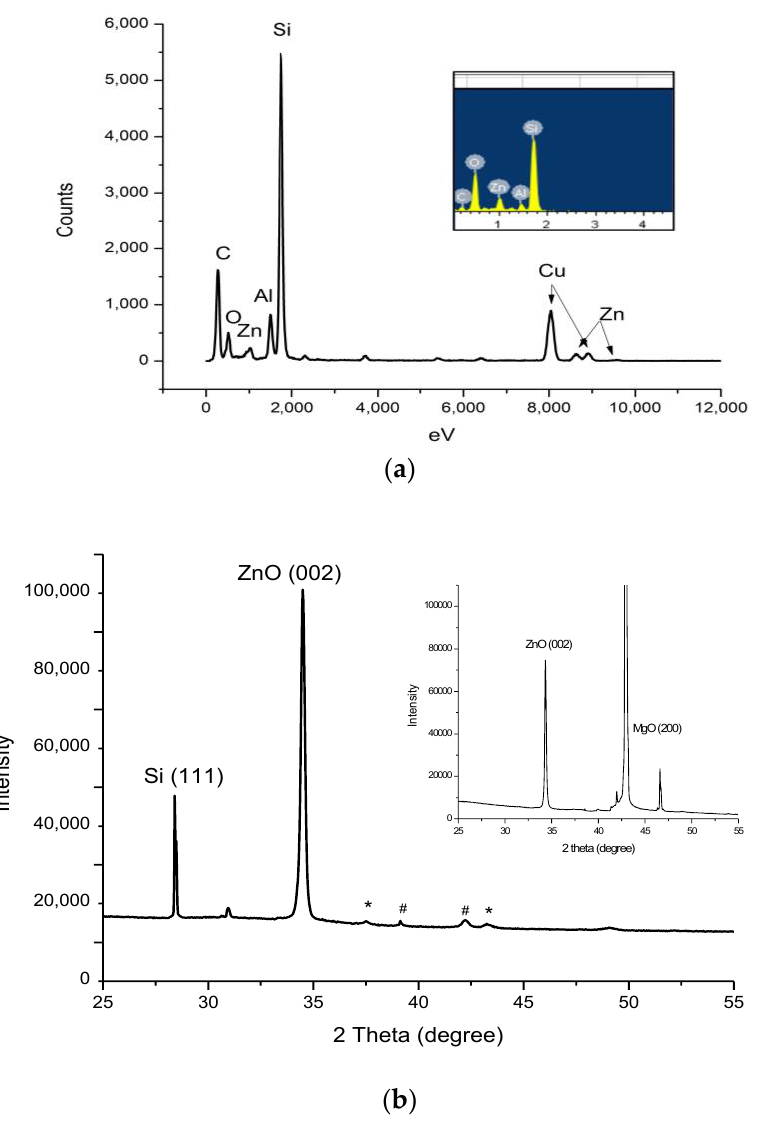
Figure 3. ( a ) EDX pattern of ZnO grown on Si (111) by PLD (ZnO) + RFMS (Al 2 O 3 ) taken by TEM. As confirmed by EDX spectrum taken from SEM, the Zn, O, and Al peaks were clearly identified (see Inset); ( b ) XRD pattern of ZnO nanostructures grown on Si (111) substrate by PLD + RFMS, showing the sharp peak corresponding to ZnO (002). Other low intensity peaks could be attributed to alumina, denoted by (*) and to metallic Zinc, denoted by (#). Inset is the XRD pattern of the ZnO nanostructures grown on MgO substrate.